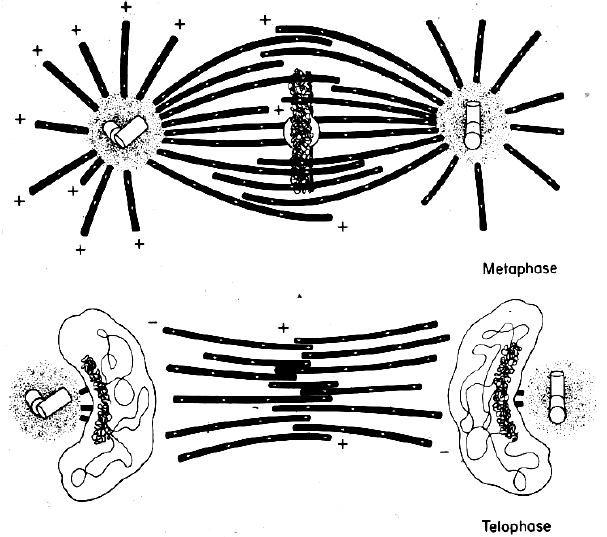
Figure 15. Diagrams showing the polar orientation of Spindle MTs, as assessed by the tubulin-containing hooks. Euteneuer and McIntosh 1981, 1982 [56,57]. This image is displayed under the terms of a Creative Commons License (Attribution-Noncommercial-Share Alike 3.0 Unported license, as described at http://creativecommons.org/licenses/by-nc-sa/3.0/.